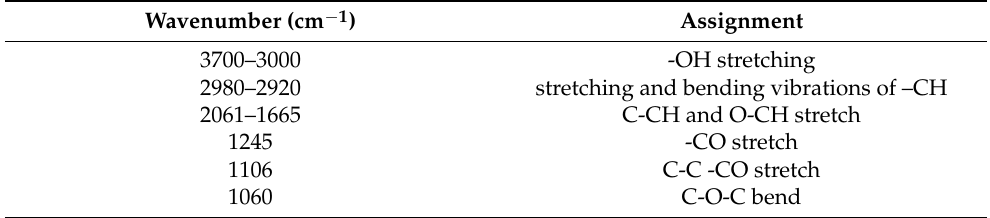
Table 2. Peak wavenumbers (cm − 1 ) assigned according to Caccamo et al. [36,37], Ramani et al. [58], and Zhang et al. [59].